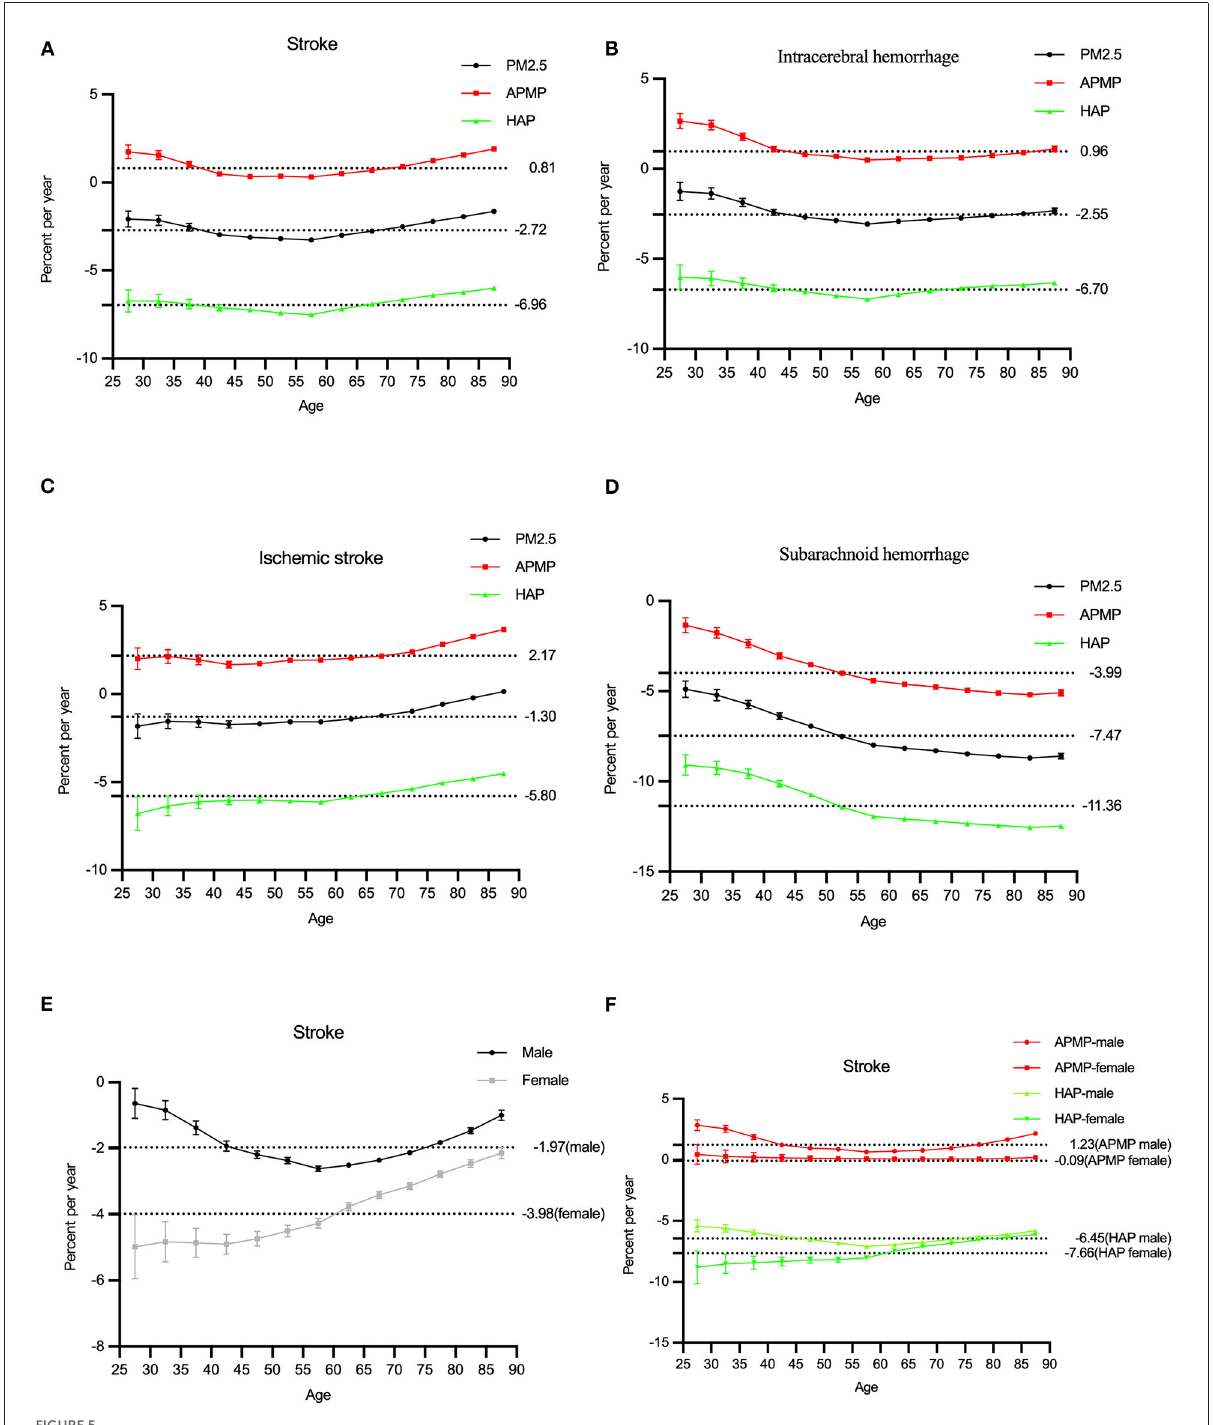
FIGURE5 The local drifts of the mortality rate of stroke attributable to PM2.5 exposure from 1990 to 2019. (A–D) The local drifts of stroke and subtypes for both sexes in PM2.5 exposure. (E) The local drifts of stroke by sex in PM2.5 exposure. (F) The local drifts of stroke by sex in ambient particulate matter pollution (APMP) and household air pollution